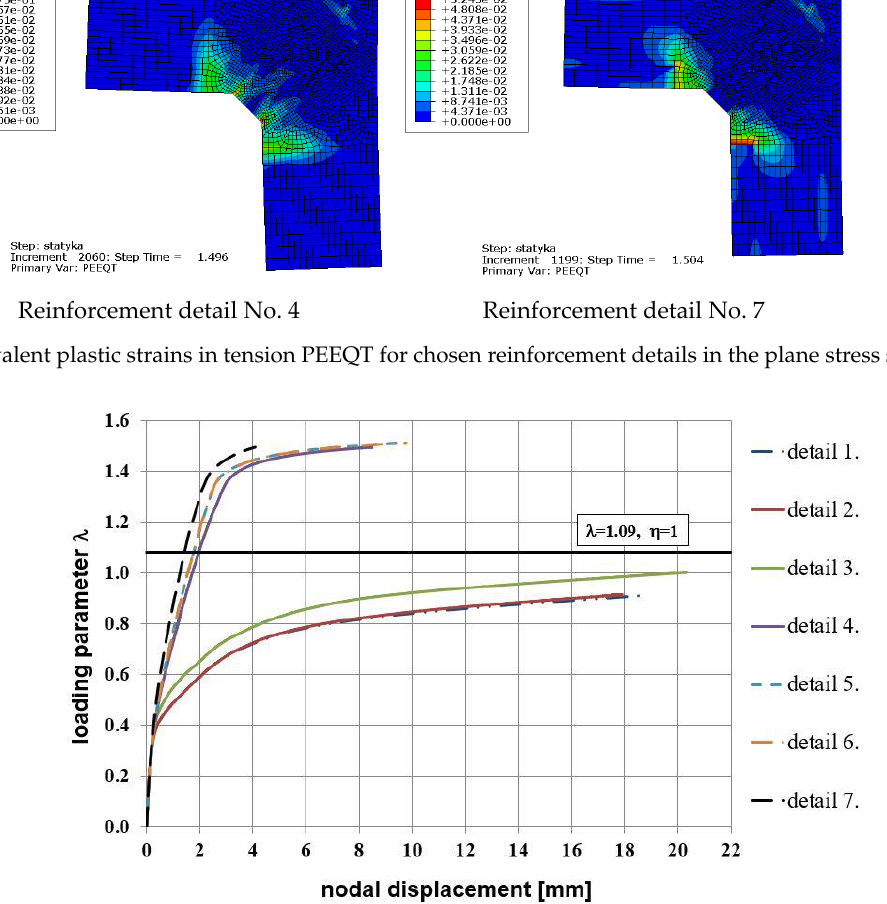
Figure 22. Crack width vs. loading parameter in the plane stress state. Values of the efficiency factors for all the details and both methods are listed in Table 7. Higher values of this factor for reinforcement details No. 4 to 7 are seen, confirming that these details are recommendable for practical use. Moreover, the results obtained with FEM in the plane stress state are comparable with those obtained with the S&T method. However, it should be remembered that a full analysis of a corner under opening bending moment demands not only the calculation of the efficiency factor but also checking the crack width. Table 7. Efficiency factors for all reinforcement details obtained using all methods (maximal val- ues in bold). Detail No.